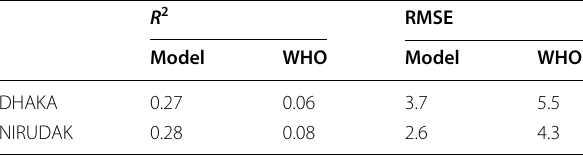
Table 2 R 2 and RMSE of forward stepwise regression models vs WHO